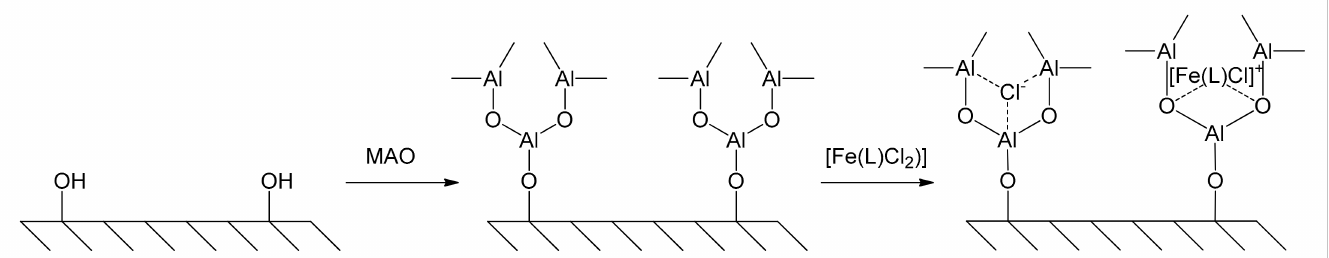
Figure 7. Immobilization of 2,6- bis [1-(2,6-diisopropylphenylimino)ethyl]pyridyl dichloro iron(II) on MCM-41 [54].